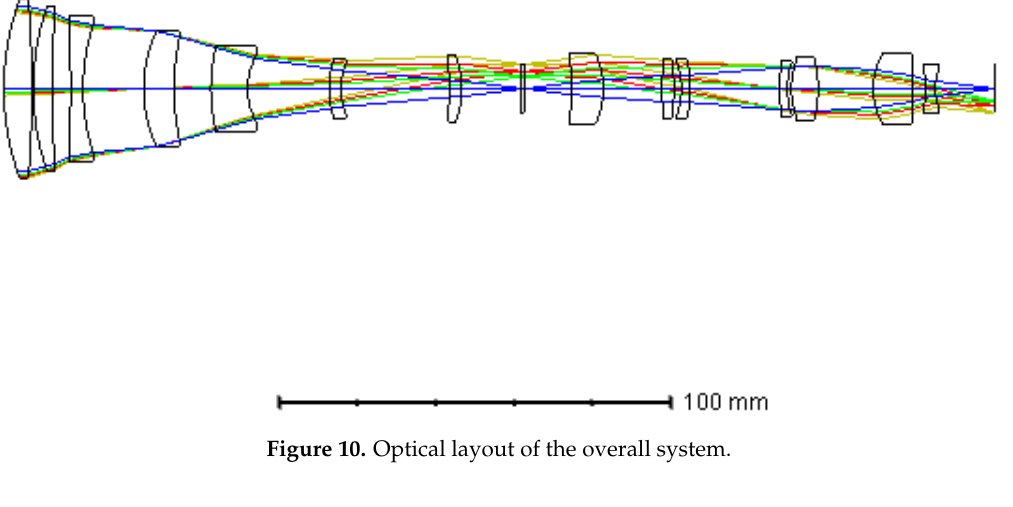
Figure 10. Optical layout of the overall system.